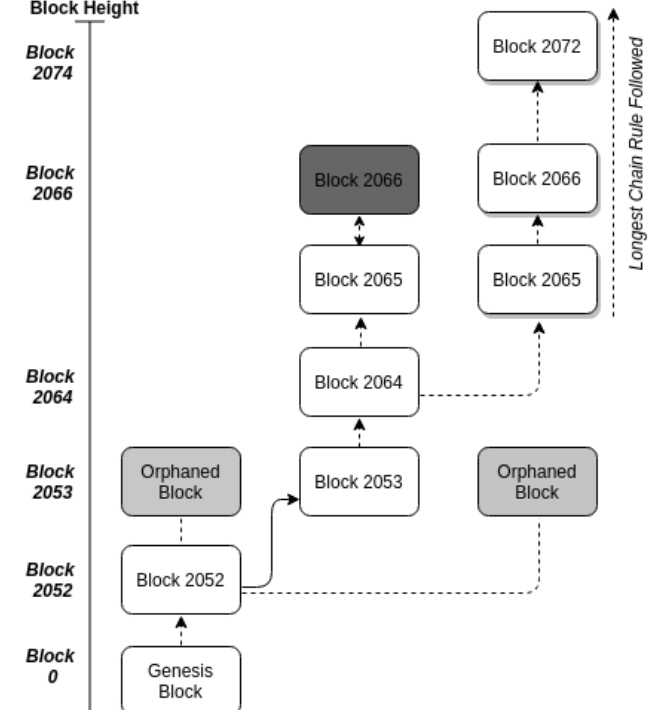
Figure 4. A scenario where three blocks are generated at the same block height 2053. Tow blocks became orphaned as the network chose to follow the block in the middle. Blocks 2065 to 2074 are privately mined blocks, which resulted in canceling transactions on the legit Block 2066. The network follows blocks from 2065 to 2074, broadcasted by the attacker, due to the longest